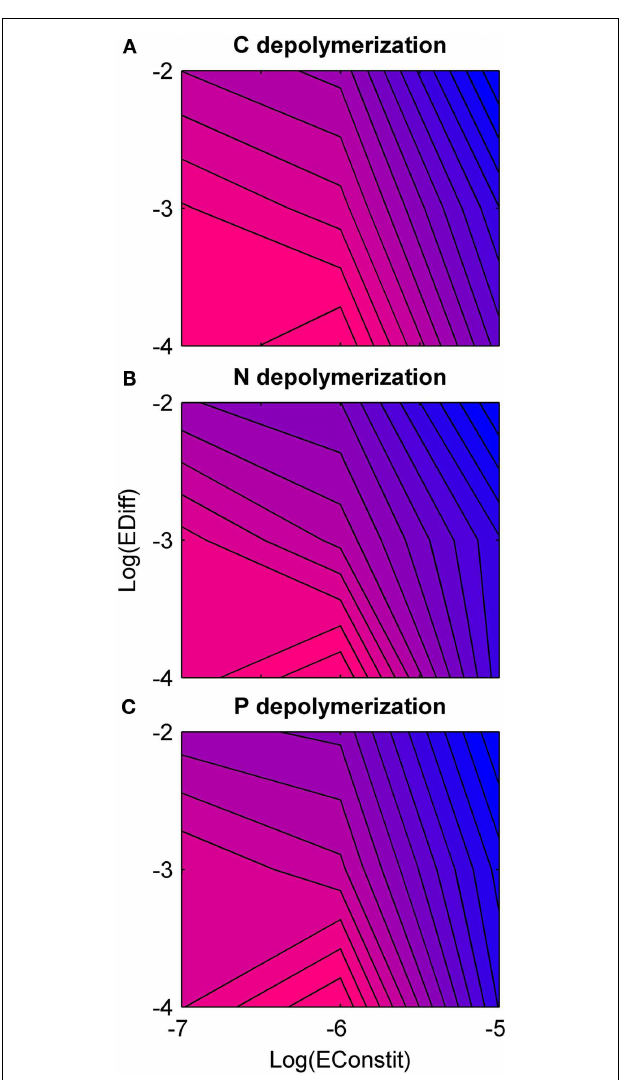
FIGURE 4 | Rate of nutrient depolymerization as a function of diffusion rate (EDiff) and constitutive enzyme production rate (EConstit) for each of the three nutrients, averaged over all replicate runs. Blue represents low rates of depolymerization, and pink high rates. (A) Carbon depolymerization. (B) Nitrogen depolymerization. (C) Phosphorous depolymerization. Across all three nutrients, the depolymerization rate is highest for intermediate production and low diffusion, and lowest for high production and high diffusion.The depolymerization rate decreases with the diffusion rate over the domain